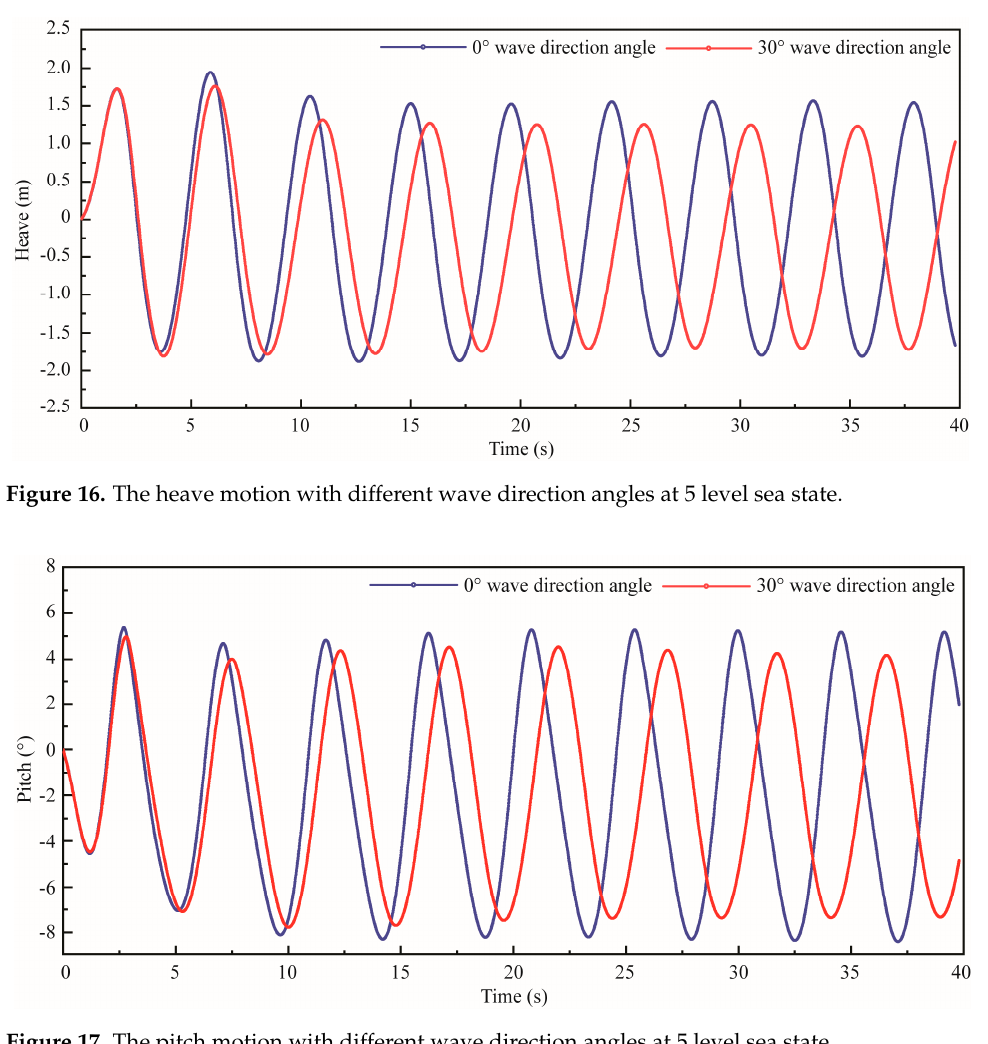
Figure 18. The roll motion with different wave direction angles at 5 level sea state. In summary, the six degrees of freedom motion of the USV under different sea states basically presents periodic changes, and the motion amplitude of the 0° wave direction was slightly greater than that of the 30° wave direction. The rolling motion was not obvious at 0°, and the motion of the USV under different sea states and does not exceed